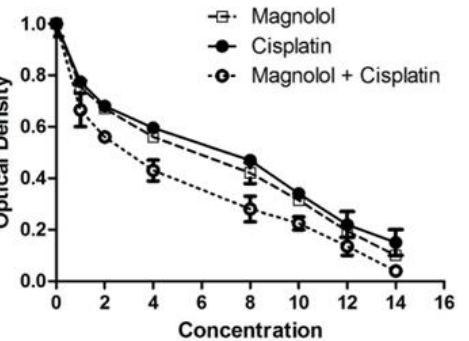
Table 1. Characteristics of primers used in qPCR test.